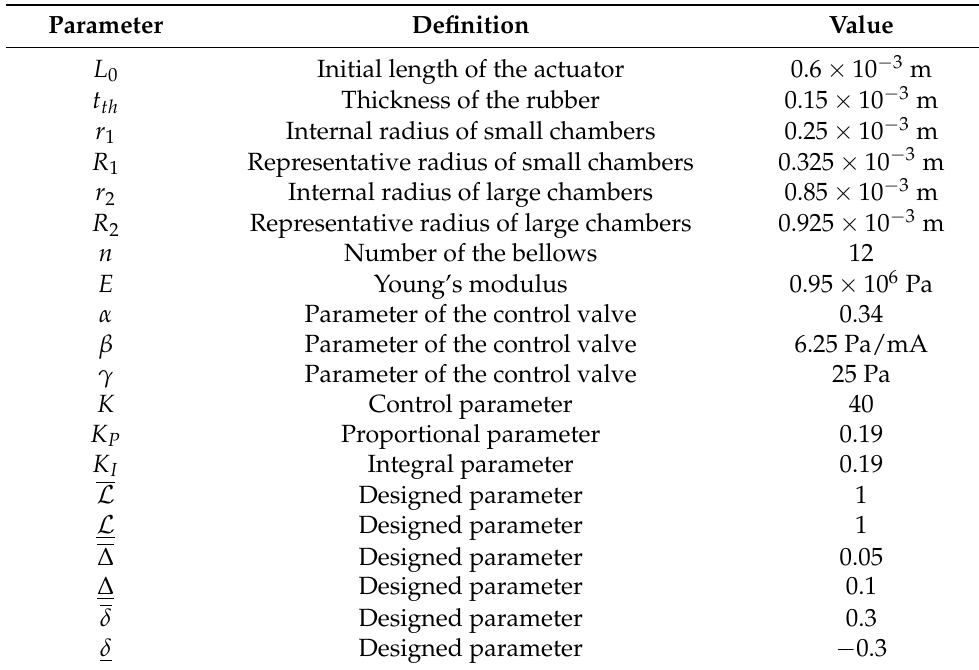
Table 3. Parameters used in the simulation and the